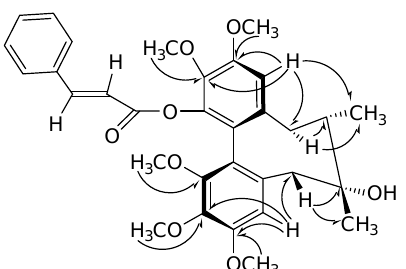
Figure 2 . Key HMBC Correlations of compound 1.